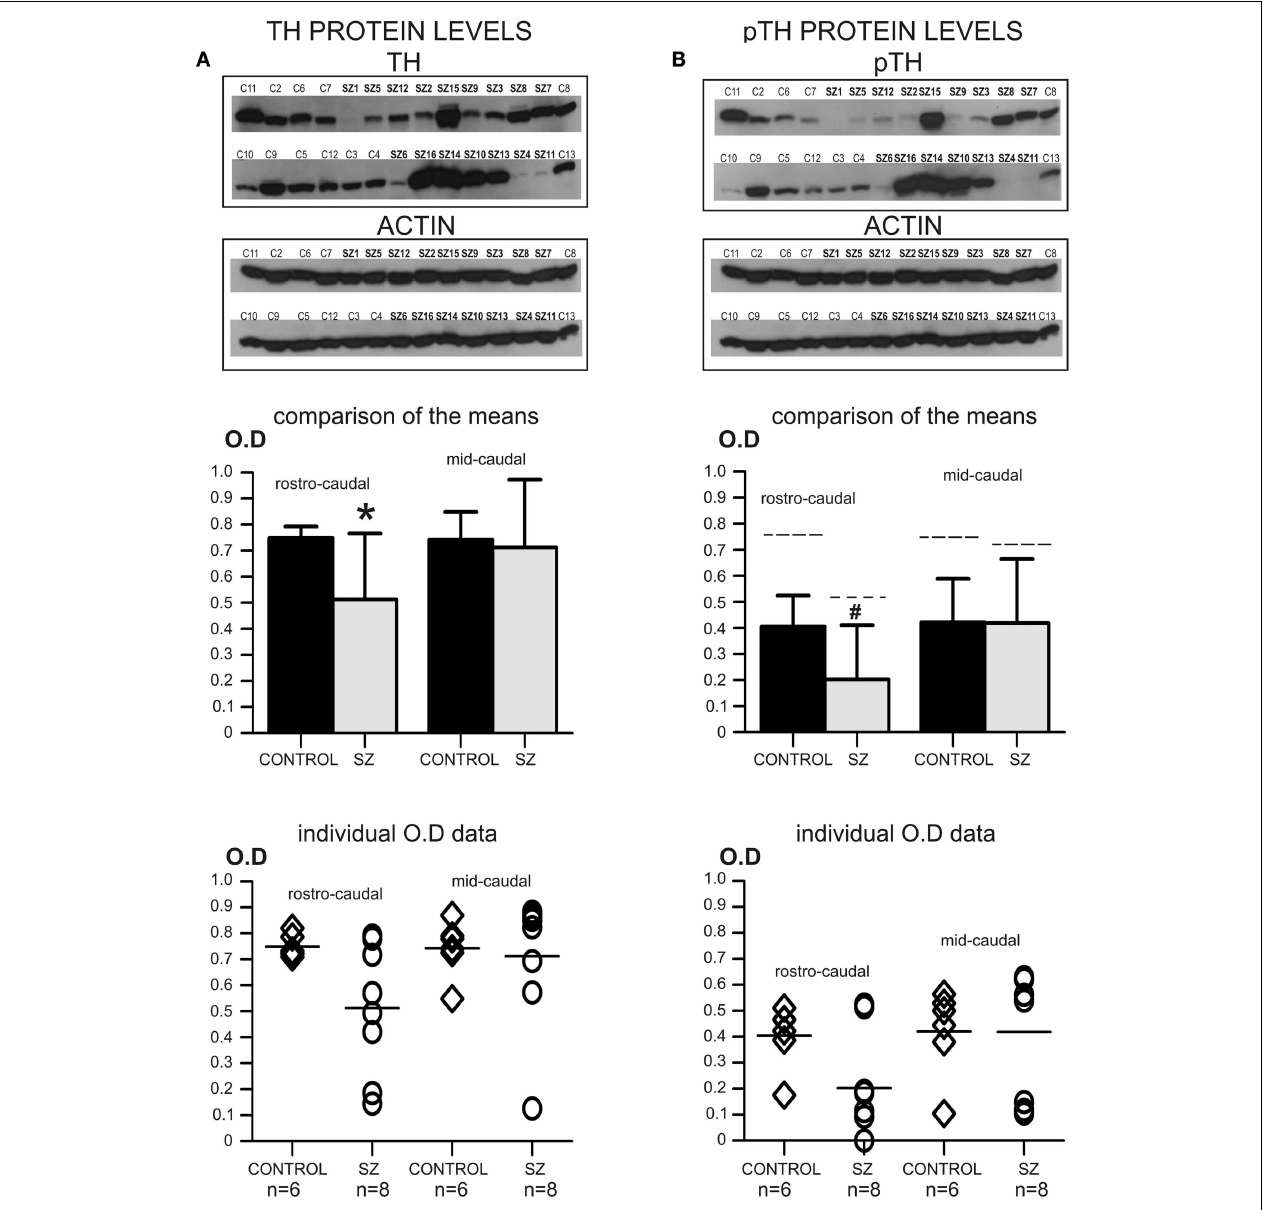
panel). In addition, reblots for actin of the same membranes are shown immediately below.The graph bar in the mid panel shows the comparison of the mean OD values for pTH in rostro-caudal and mid-caudal samples. Even when there were no significant differences in pTH OD values between controls and schizophrenia in rostro-caudal samples, a trend ( # ) toward significance was observed ( P = 0.056; OD mean ± SD: control rostro-caudal = 0.405 ± 0.120, schizophrenia rostro-caudal = 0.203 ± 0.208; control mid-caudal = 0.421 ± 0.168, schizophrenia mid-caudal = 0.419 ± 0.246). For comparison, the dashed line on top of each of the individual bars indicates the mean level of totalTH for each group.The ratio of pTH versus totalTH for each group was as follows: control rostro-caudal = 54.07%, schizophrenia rostro-caudal = 39.57%; control mid-caudal = 56.66%, schizophrenia mid-caudal = 58.85%.The bottom panel shows a scatter plot for the individual pTH OD data.The horizontal bar in the scatter plot indicates the mean OD value for each